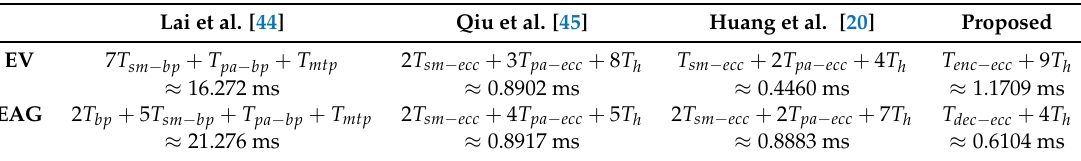
Table 3. Computation costs for related